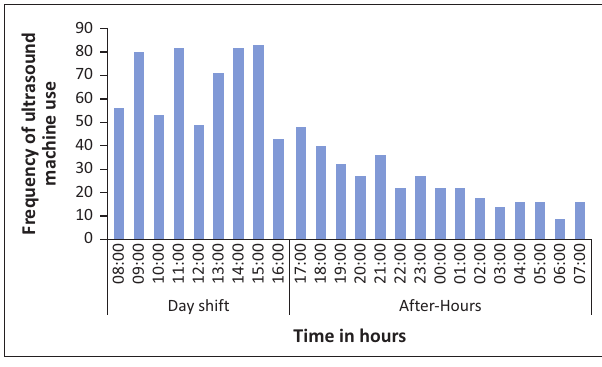
N = 964. FIGURE 5: Frequency of ultrasound machine use by time of use from 01 September 2019 to 31 March 2020.